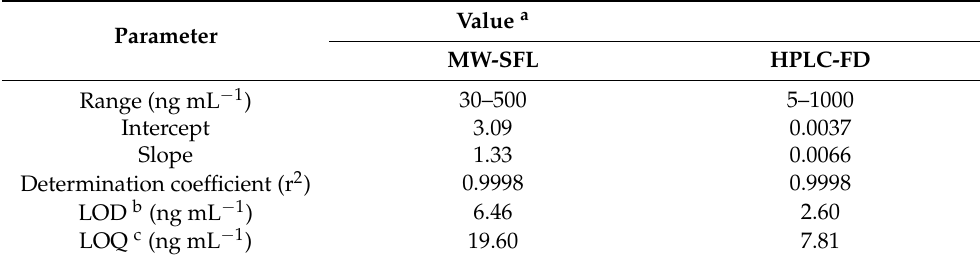
Table 3. Regression and statistical parameters for the determination of ALC by the proposed MW-SFL and HPLC-FD methods.